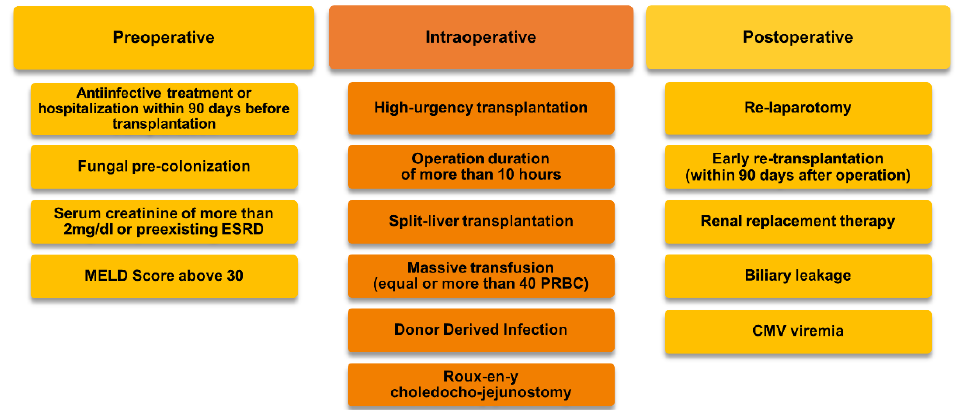
Figure 1. Perioperative risk factors for invasive fungal infections. Abbreviations: MELD: Model for End-Stage Liver Disease Score, ESRD: end-stage renal disease, PRBC: packed red blood cells, CMV: cytomegalovirus.